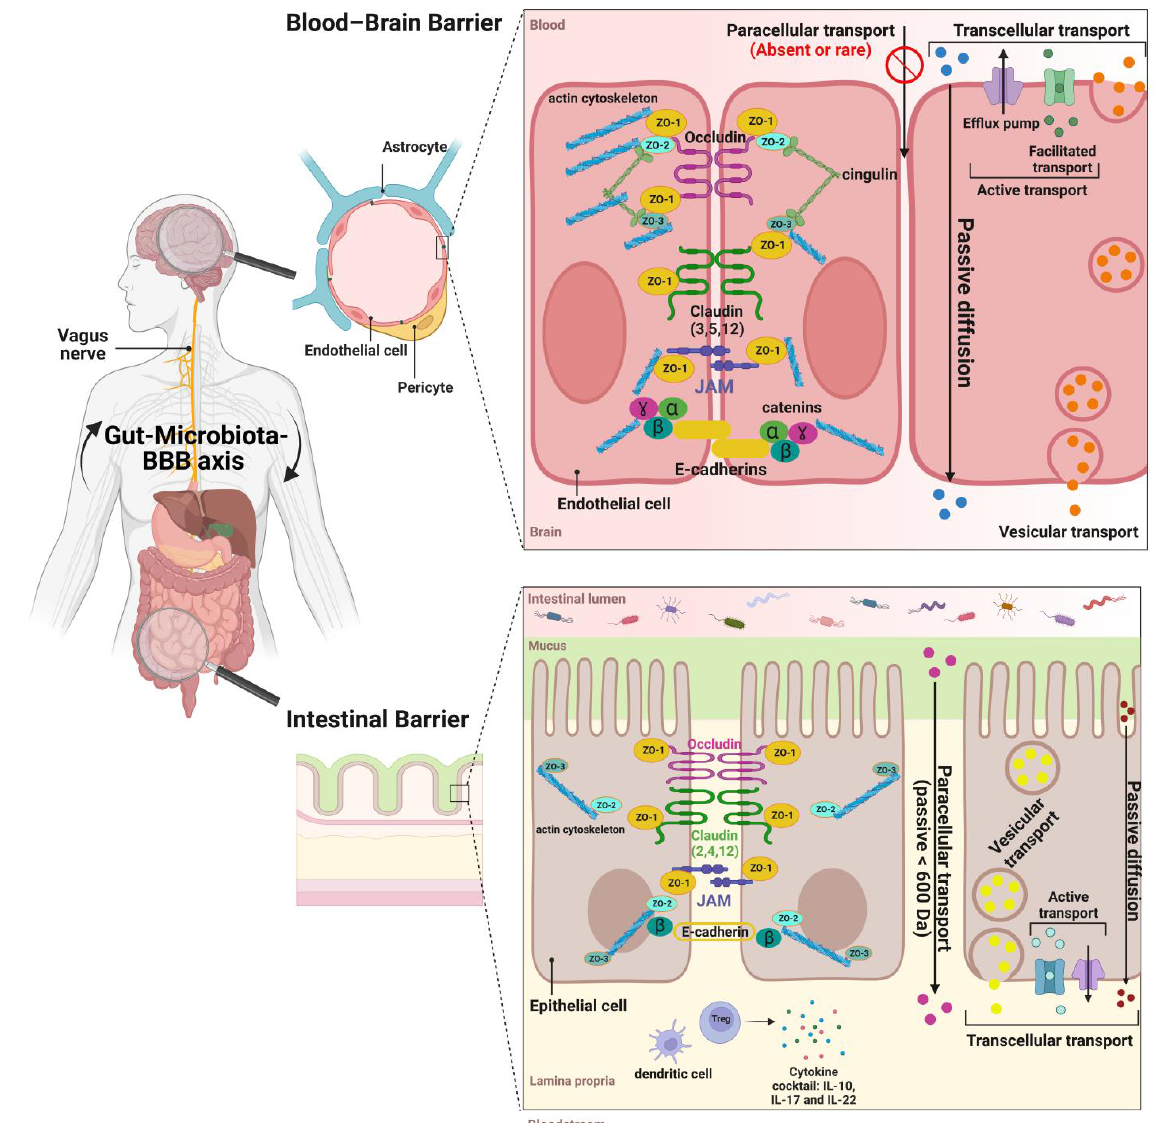
Figure 2. Similarities and differences between the intestinal barrier (IB) and blood–brain barrier (BBB). The IB is made up of epithelial cells separating the gut lumen from the internal space, whereas the BBB is formed by endothelial cells (ECs) lining the blood vessels separating lumen of blood vessels from the central nervous system (CNS) parenchyma. The first defense component of the IB, separating the microbiota from the epithelial cells, is the intestinal mucosa: mucus layer composed of highly glycosylated mucin proteins, defensins, Immunoglobulin A (IgA), and the inner lamina propria where T-regs (regulatory T cells) and resident dendritic cells maintain an anti-inflammatory environment by secreting an appropriate cocktail of cytokines. Each barrier tightly regulates the movement of molecules and ions between the cellular spaces through paracellular (rare in the BBB) and transcellular transports (diffusion, vesicular, and active). The active transport is ensured by efflux pumps and specific transporters. Thus, these two barriers are considered physical, immunological, and dynamic barriers protecting the host against food contaminants and pathogens. The molecular composition of BBB endothelial tight junctions, ensuring paracellular passage restrictions, shows remarkable similarities to those in epithelial cells (but more stringency at the BBB) as they are formed by strands of occludin, claudin molecules, and JAM (junction adhesion molecules) that are linked to the cytoskeleton by zonula occludens (ZO-1, 2, and 3) as well as intracellular proteins (e.g.,